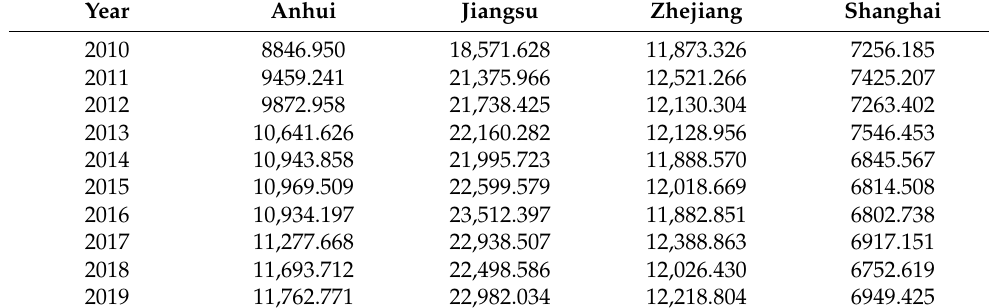
Table 2. Carbon emissions in the YRD Region from 2010 to 2019 (unit: 10,000 tons). Year Anhui Jiangsu Zhejiang Shanghai